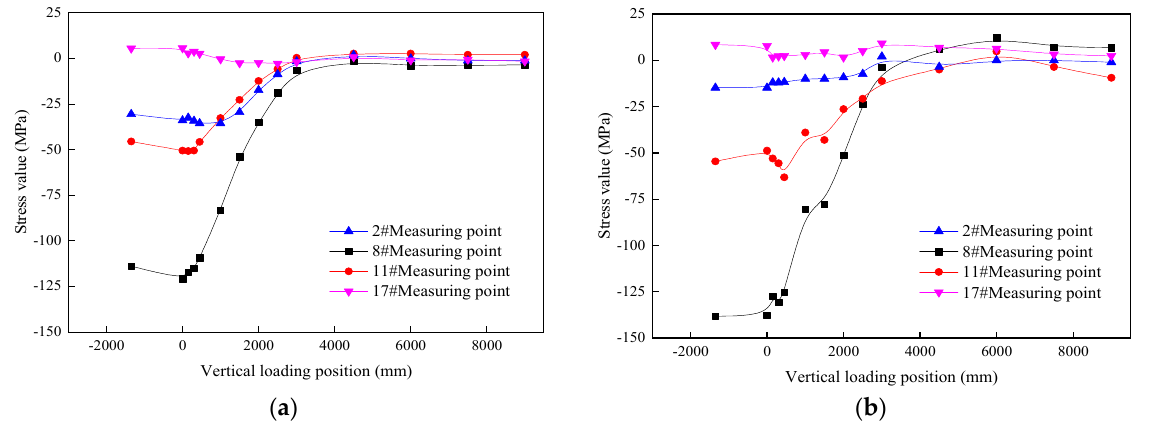
position of 0 mm, the stress peaks of the two loadings were about − 125 MPa and − 140 MPa, respectively, and the tested stress value was the largest.